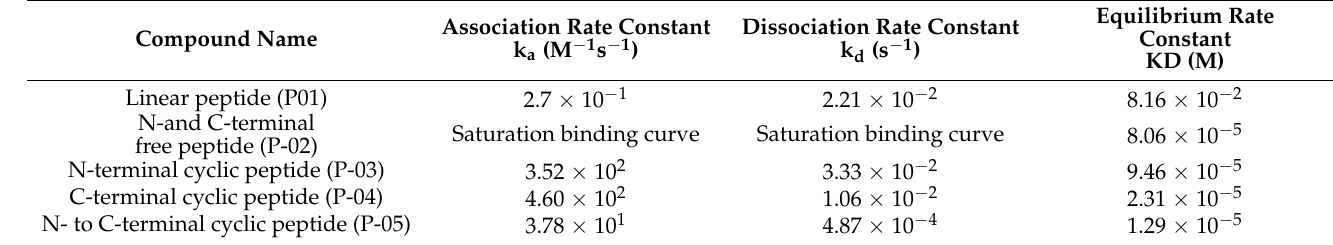
Table 2. Association and dissociation rate constants of the peptides.